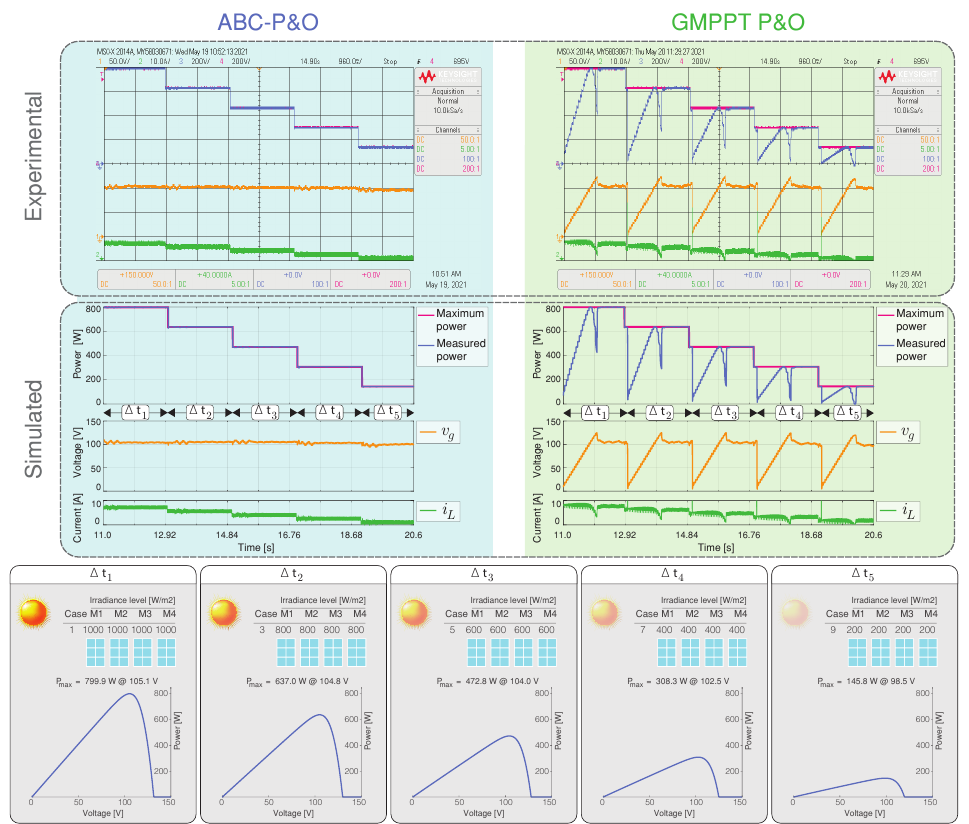
Figure 9. Simulated and experimental dynamic behavior of the MPPT algorithms for Scenario 2 with an output voltage V o = 160 V. The proposed MPPT algorithm (right) is compared with the GMPPT P&O algorithm (right). CH1: v g (50 V/div), CH2: i L (10 A/div), CH3: maximum power (200 W/div), CH4: measured power (200 W/div), and a time base of 960